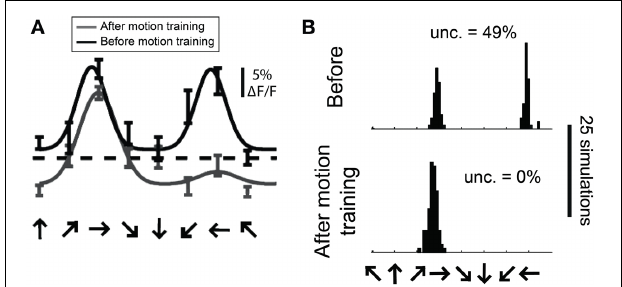
FIGURE 13 | Estimating the distribution of preferred direction using bootstrap methods. (A) Data from a cell recorded with 2-photon calcium imaging using OGB-1AM before and after extended exposure to a motion stimulus (“motion training”). Bars show ± 1 standard error of the response. Solid lines show best fits with double Gaussian functions. The dashed line indicates mean response to a gray screen. (B) Distribution of preferred directions in bootstrap simulations of the cell shown in (A) . The data from this cell was randomly resampled with replacement, creating a “simulated” cell, and this simulated data set was fit with double Gaussian functions. This procedure was repeated 100 times in each training condition, yielding the observed distributions of preferred direction. “Unc.” lists the preference uncertainty, meaning the percentage of simulations whose preferred direction differed from the mean direction by more than 90 ◦